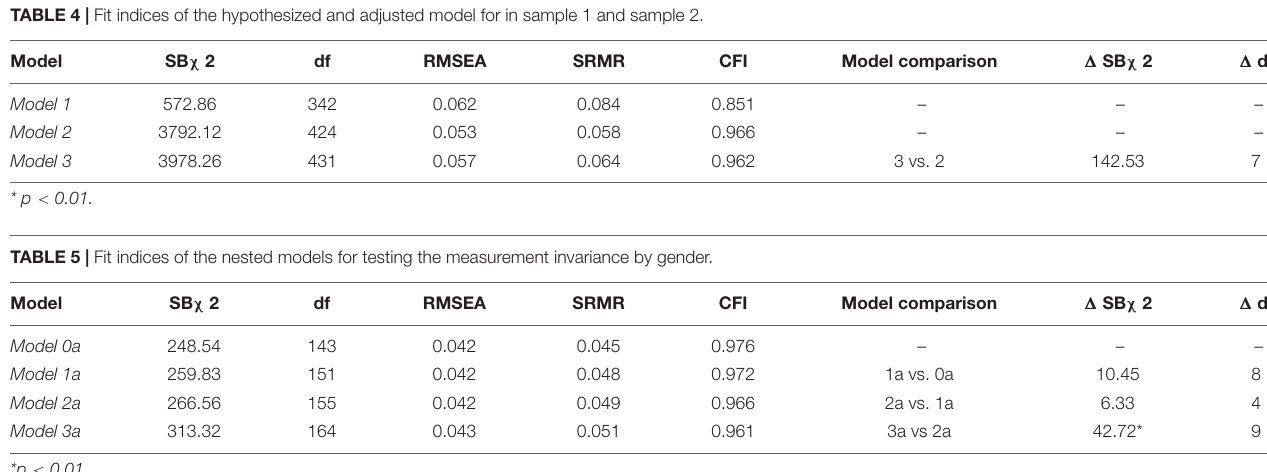
TABLE 6 | Fit indices of the nested models for testing the measurement invariance by educational degree. Model Model